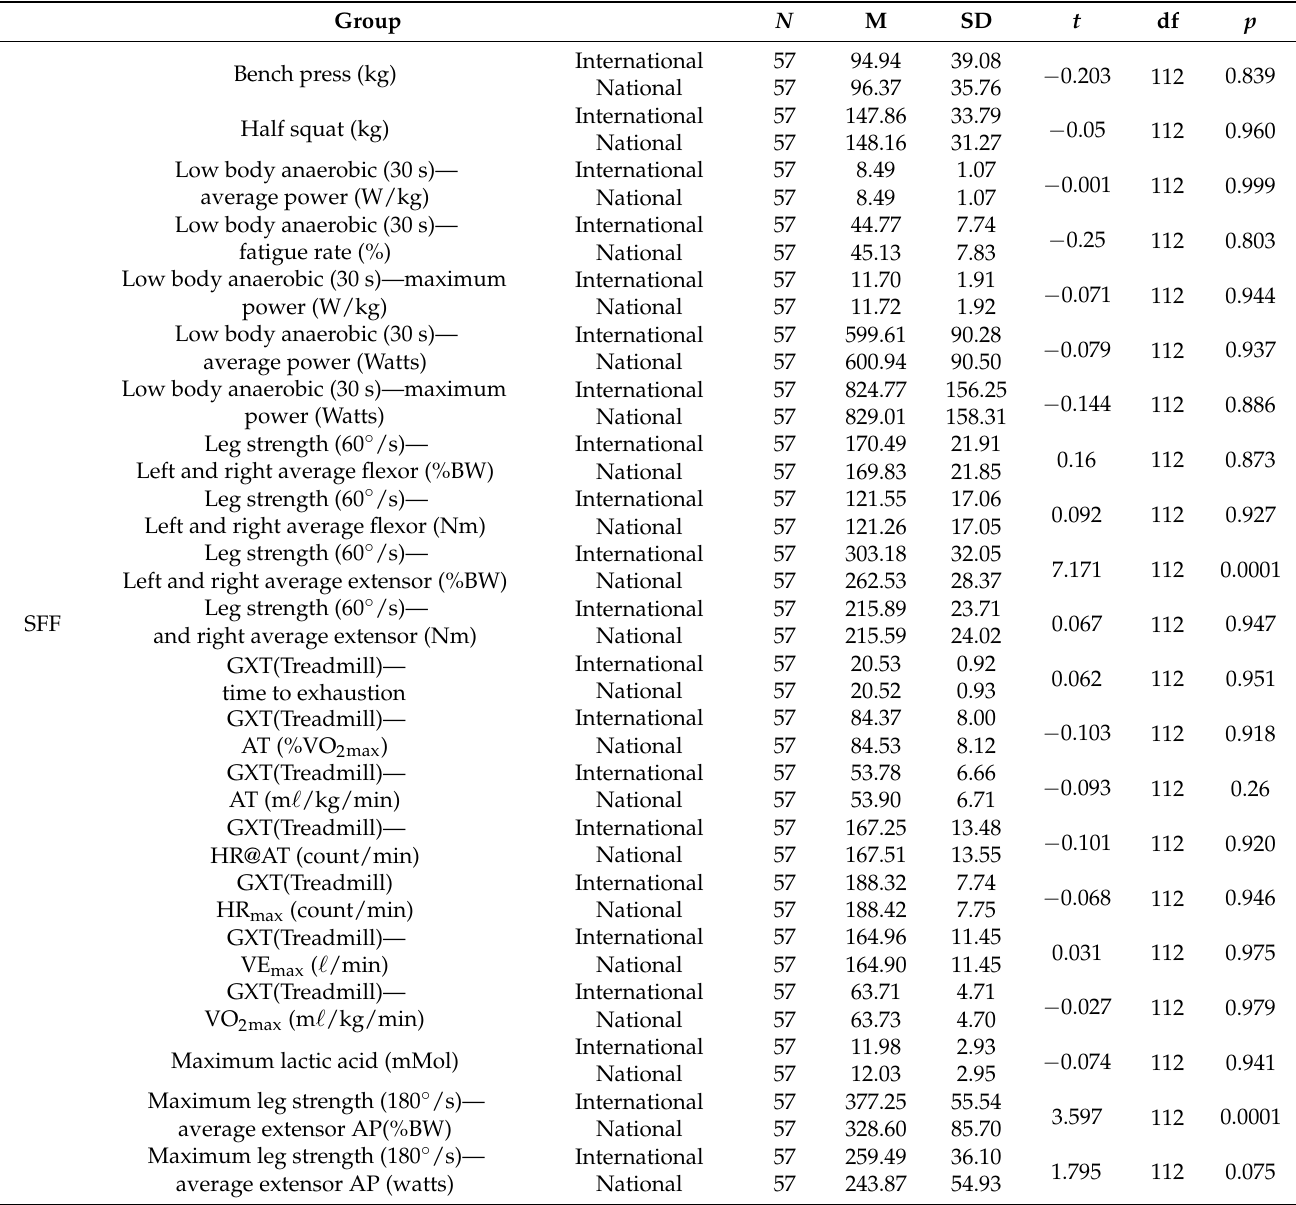
Table 6. Comparison of national and international averages of specific fitness